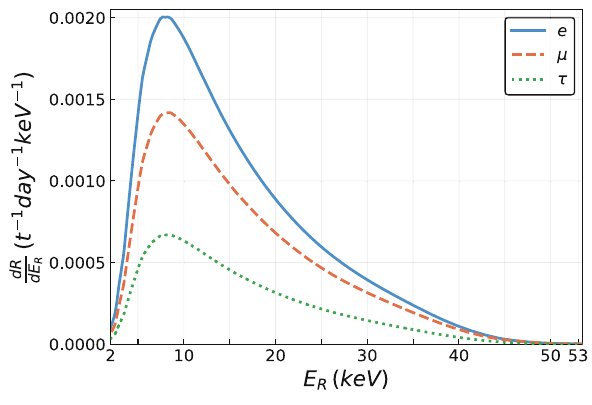
F and a scalar S in the loop we fix m F = 600 GeV, m S = 500 GeV, y V = 1 and y A = 1 . 3 e i 1 . 4 . In the case of a right-handed τ lepton we fix m S = 1000 GeV and y 1 = 1